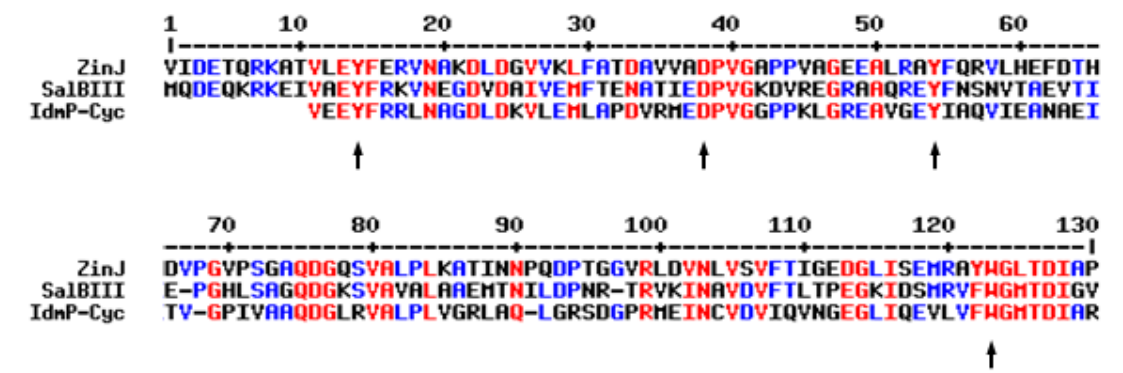
Figure 4: MultAlin [51] sequence alignment of ZinJ with the epoxide hydrolases SalBIII and IdmP-Cyc from salinomycin and indanomycin biosynthesis [45], [46]. Selected amino acid residues of the active site cavity [44] are indicated with